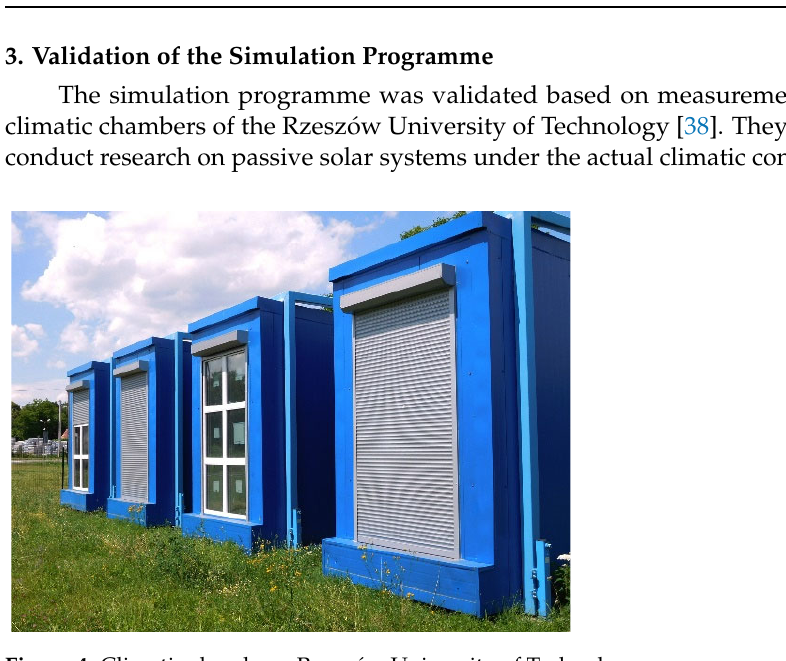
Figure 4. Climatic chambers, Rzeszów University of Technology.